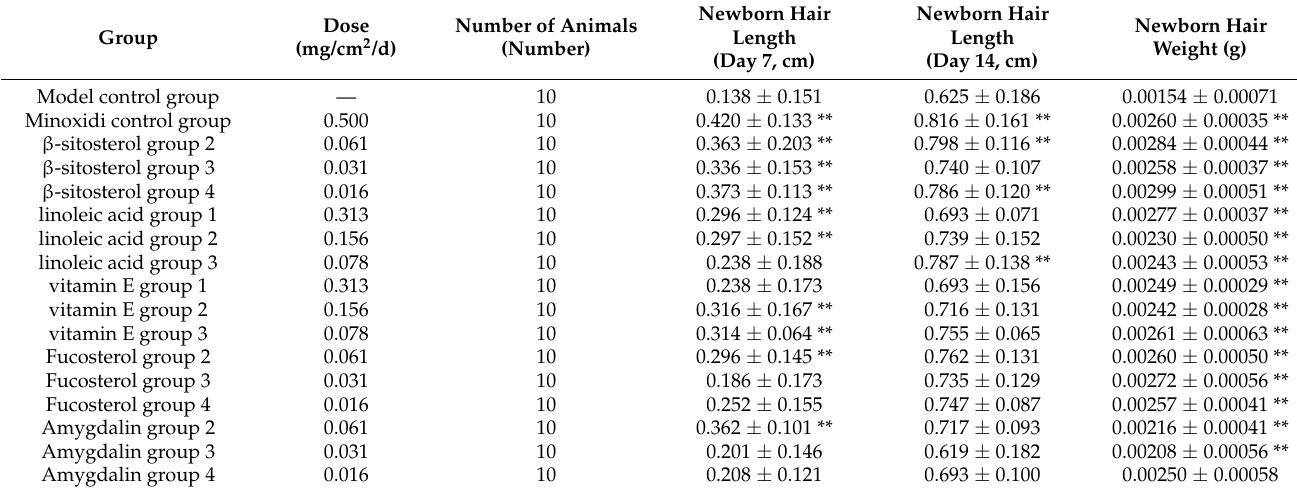
Table 15. Effects of five active ingredients in the kernel of P. mira on the newborn hair length and weight of C57BL/6 mice depilation model induced by sodium sulfide.